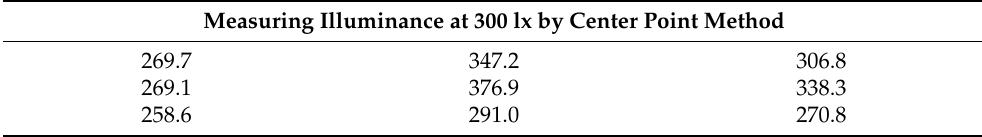
Table 2. Measuring illuminance at 300 lx using the center point method.